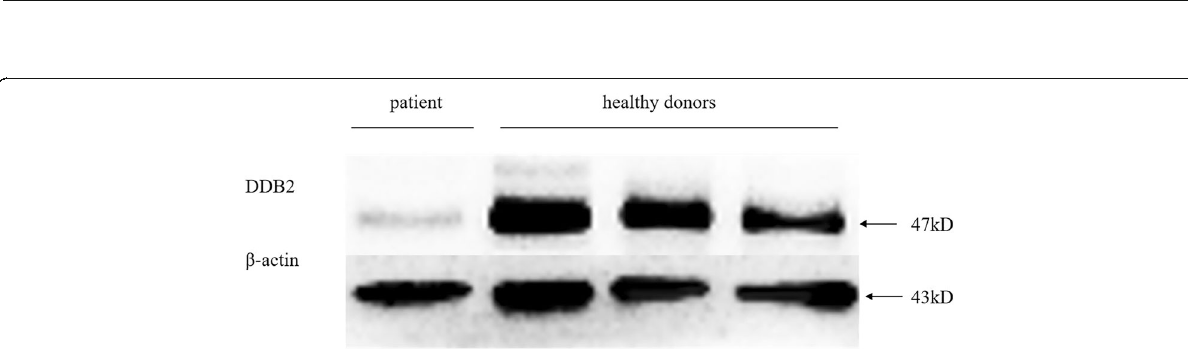
Fig. 3 Western blotting analysis revealed that the patient lacked the expression of the wild-type mature DDB2